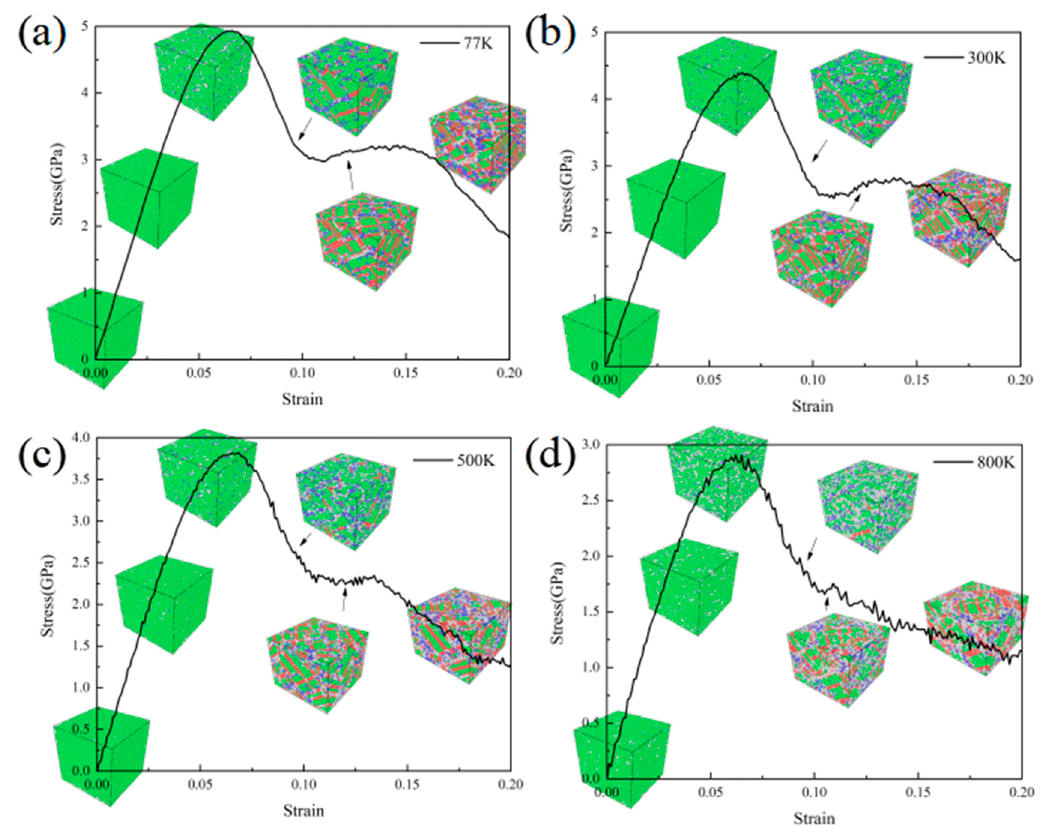
Figure 3. Stress and structural evolution of CoCrNi SCs at 77 K ( a ), 300 K ( b ), 500 K ( c ), and 800 K ( d ). Green, blue, and red represent the atoms of FCC, BCC, and HCP structures, respectively. The arrows indicate the microstructure of the alloy when the strain is 0%, 3%, 6%, 9%, 12% and 15%.